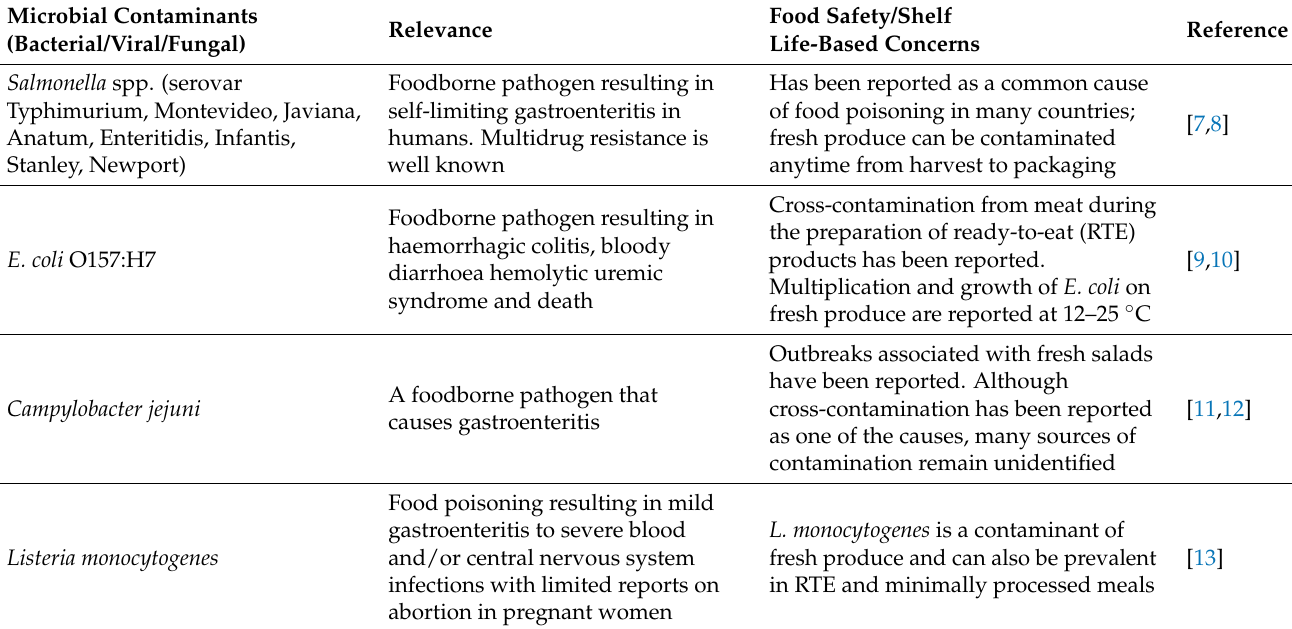
Table 1. Common contaminants of fruits and